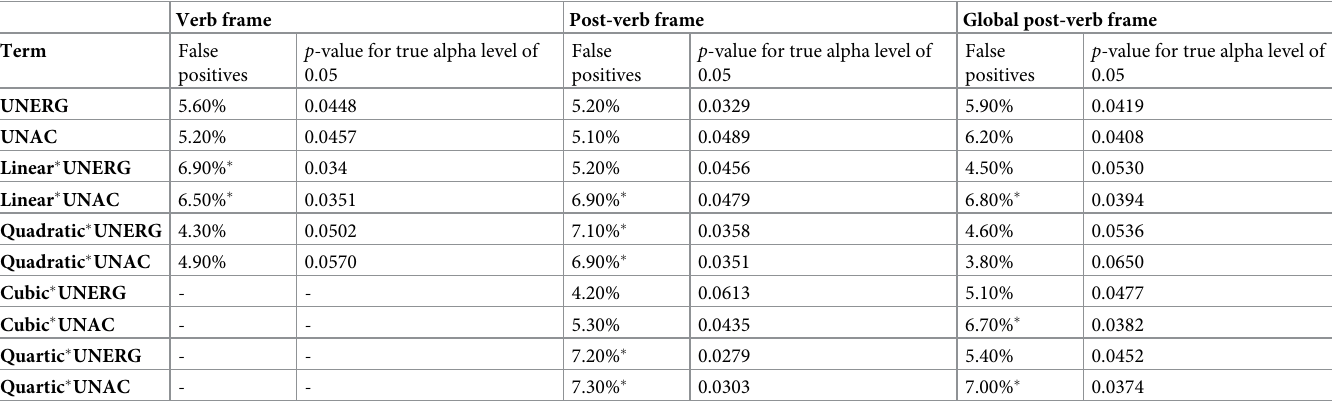
Table 9. Resampling analysis across the three time